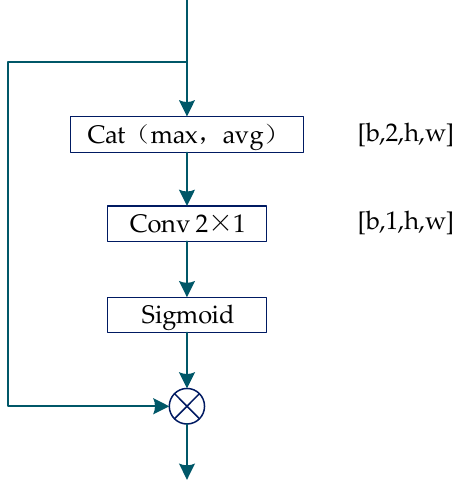
Figure 10. Spatial Figure 10. Spatial attention.